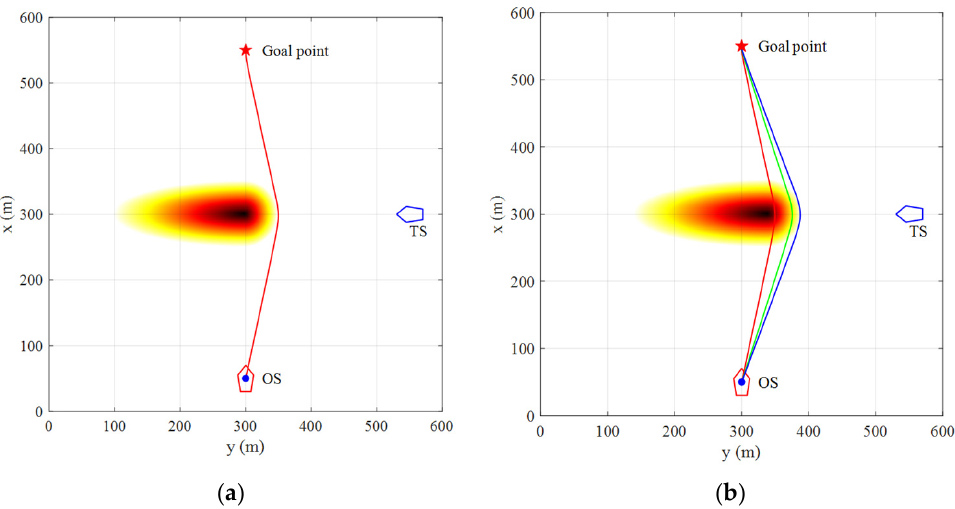
Figure 5. The preliminary path and the path optimization process of the proposed approach. ( a ) The preliminary path, ( b ) The path optimization process. preliminary path, ( b ) The path optimization